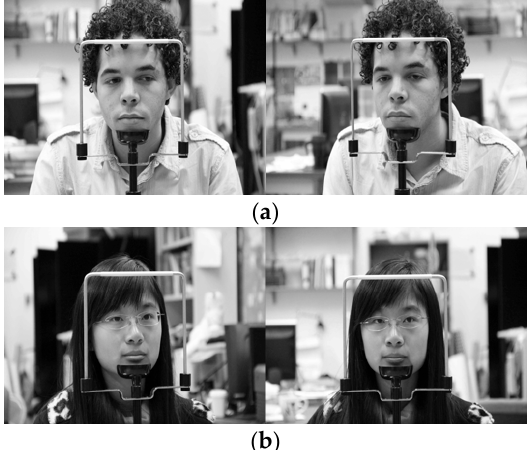
Figure 24. Examples of incorrect classification of frontal face image. ( a ) Right image selected; ( b ) Left image